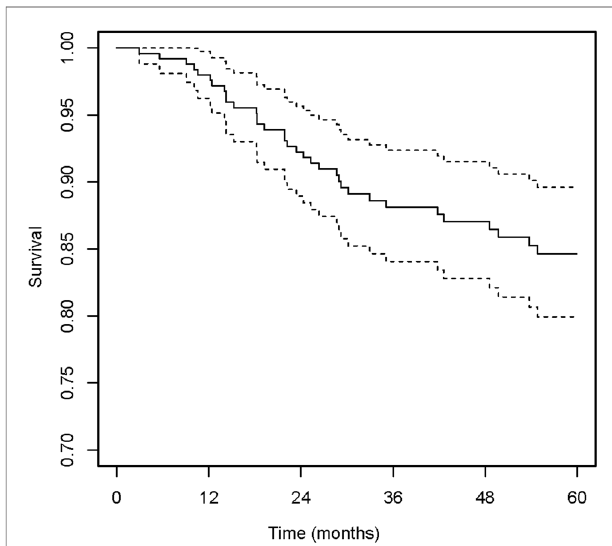
FIGURE 1 | The Kaplan-Meier survival curve of the entire cohort.